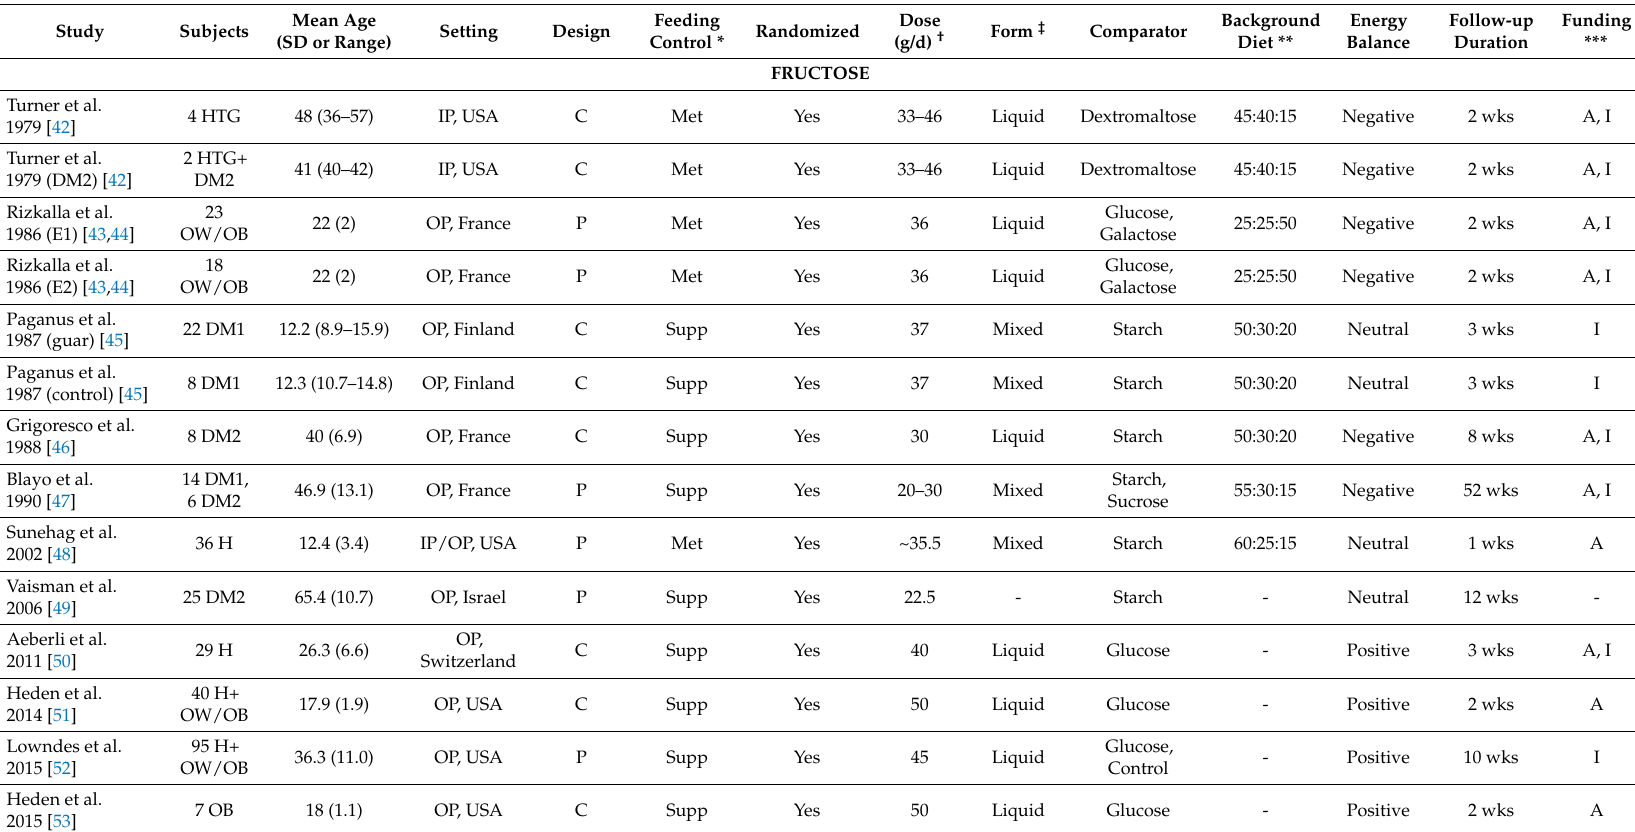
Table 1. Characteristics of included